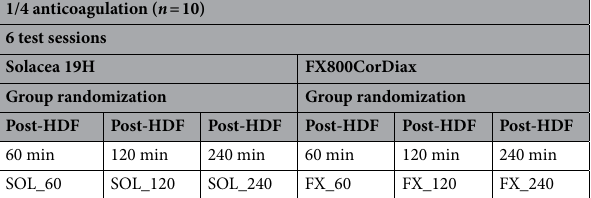
Table 4. Test protocol. Post-HDF: post dilution